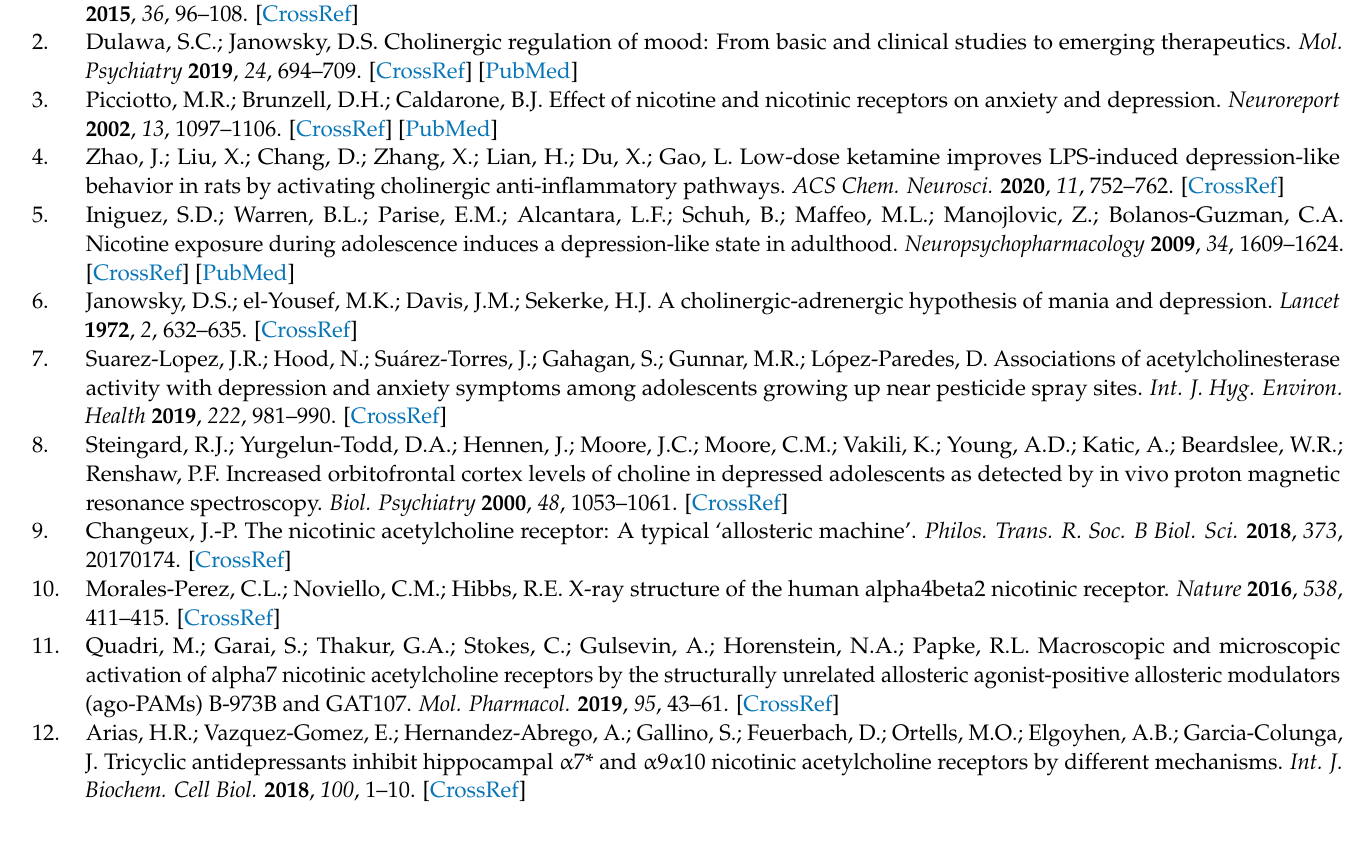
nAChR. Supplementary Table S2. Results for Biological Activity, MMGBSA, and molecular docking. Supplementary Table S3. Amino acid residues that contact